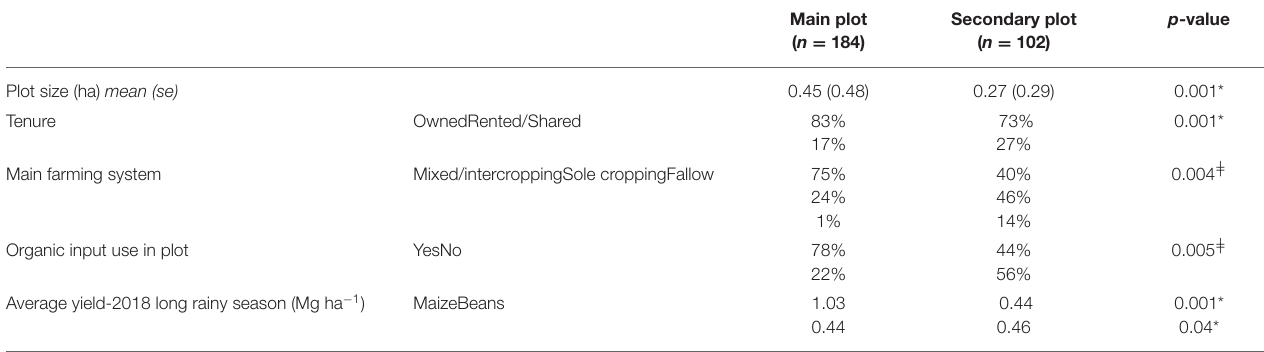
TABLE 6 | Characterization of farming systems and organic input use in the main plots vs. secondary plots in smallholder systems from western